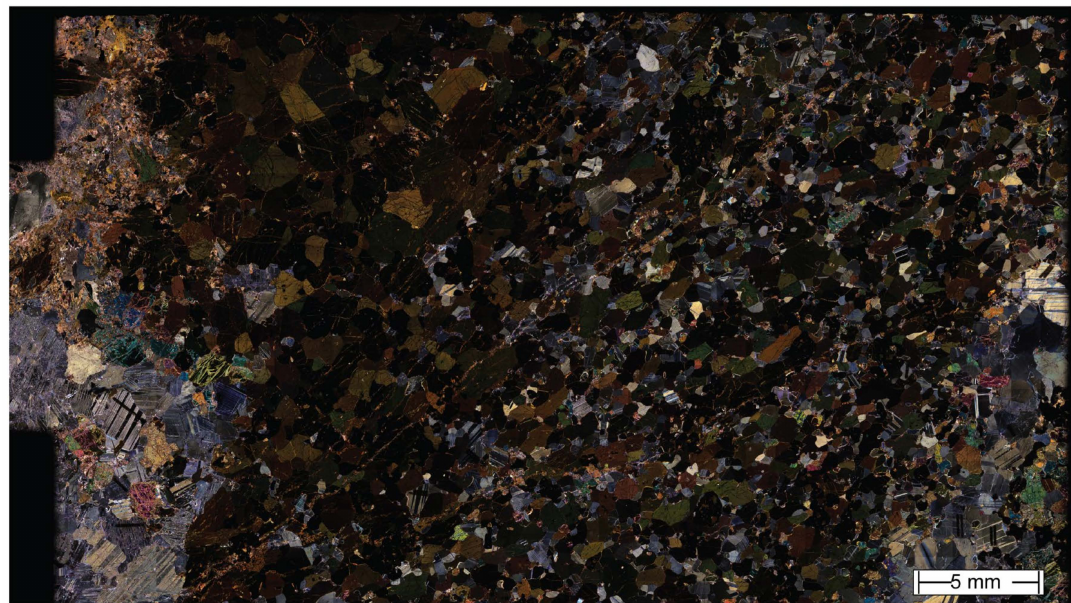
Figure 12. XPL-min image of granulite-facies metabasite KB-63. It allows seeing areas of clay (prominently in the top-left) altering plagioclase, amphibole, and garnet (possibly kelyphite). Further, note the clay-filled micro-fractures that are oriented NE across the thin section. The sub-grain structural complexity of plagioclase can also be interpreted in